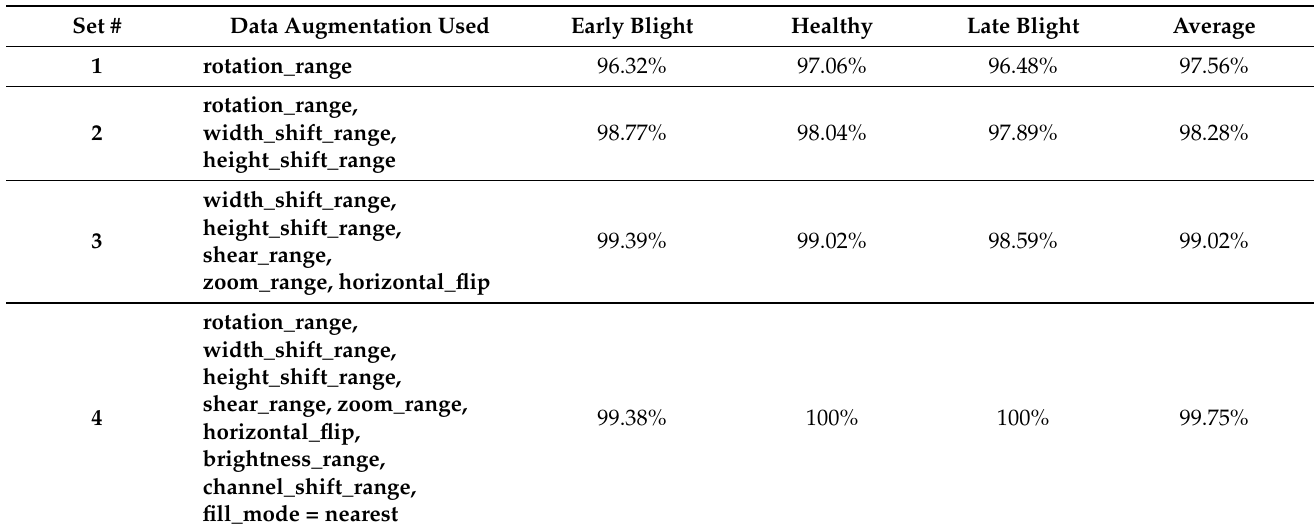
Table 6. Classification accuracies on different sets of data augmentations of the proposed PDDCNN model on the PLD dataset.